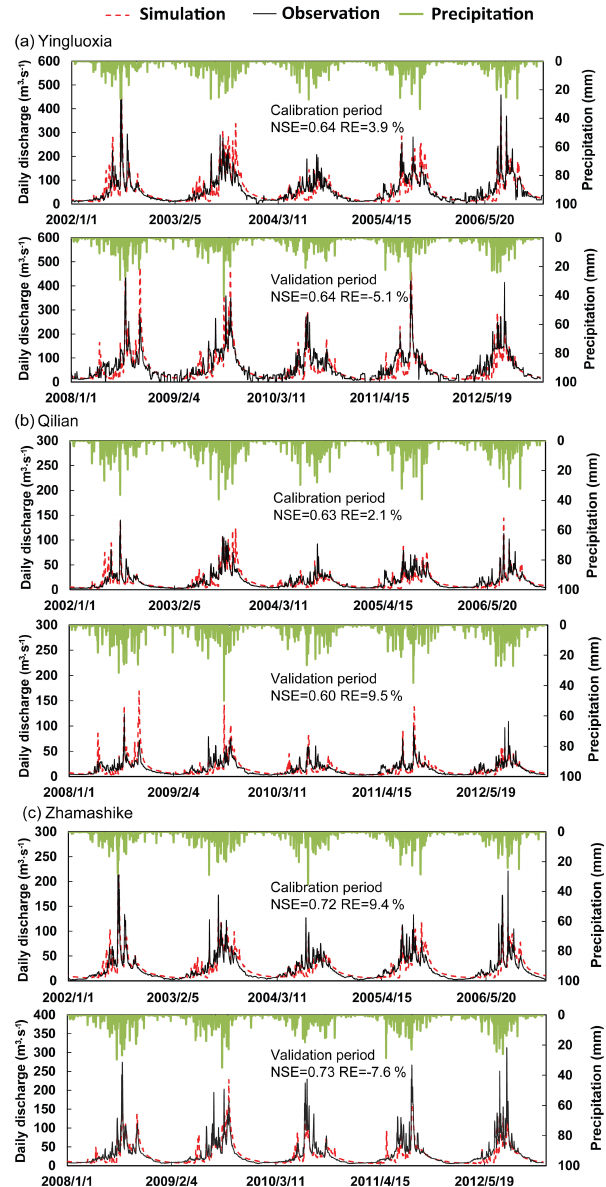
Figure 6. Comparison of the simulated and the observed daily river discharge at (a) the Yingluoxia gauge, (b) the Qilian gauge, and (c) the Zhamashike gauge. For each gauge, the upper and lower pan- els show the calibration and validation periods, respectively. NSE and relative error coefficients are